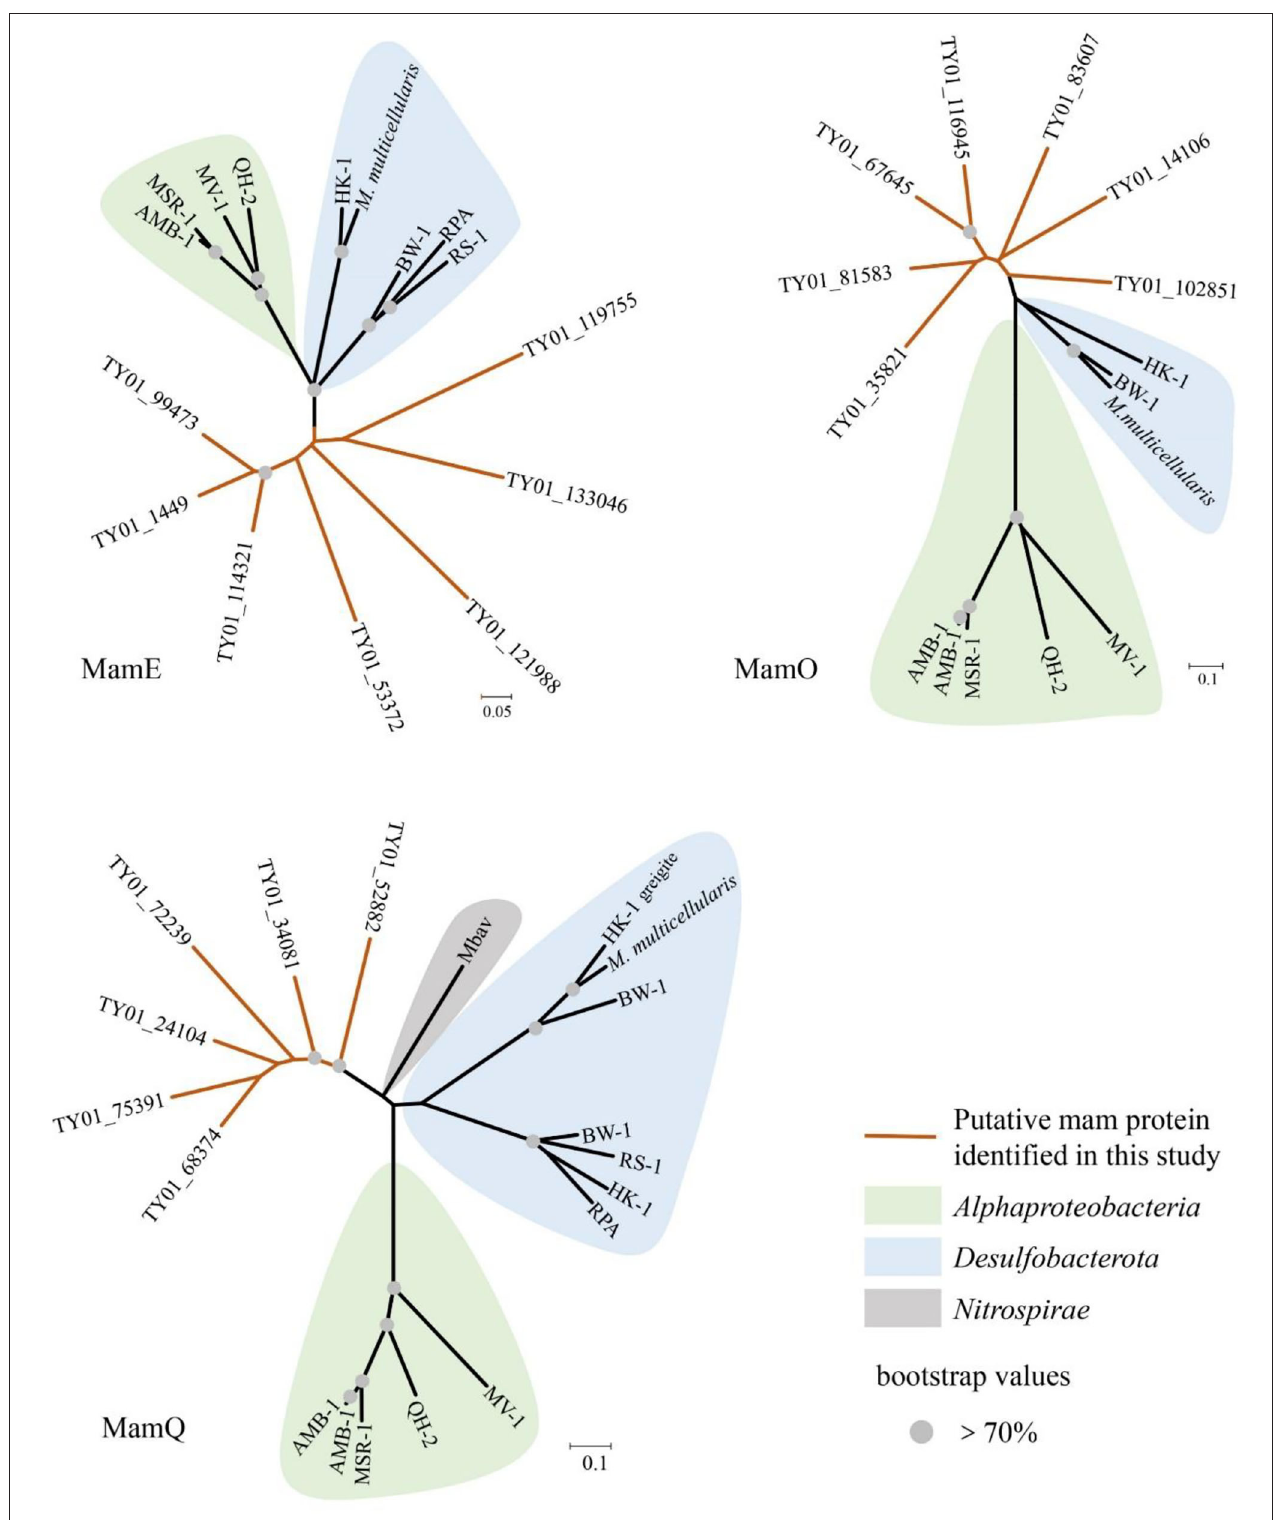
FIGURE 6 | Neighbor-joining tree of homologous sequences of MamE, MamO, and MamQ protein from sediment of Tangyin hydrothermal field. HK-1, Candidatus Magnetomorum HK-1; RPA, Candidatus Magnetananas rongchenensis; BW-1, Desulfamplus magnetovallimortis BW-1; M. multicellularis , Candidatus Magnetoglobus multicellularis Araruama; RS-1, Desulfovibrio magneticus RS-1; QH-2, Magnetospira sp. QH-2; MV-1, Magnetovibrio blakemorei MV-1; AMB-1, Magnetospirillum magneticum AMB-1; MSR-1, Magnetospirillum gryphiswaldense MSR-1; Mbav, Candidatus Magnetobacterium bavaricum .